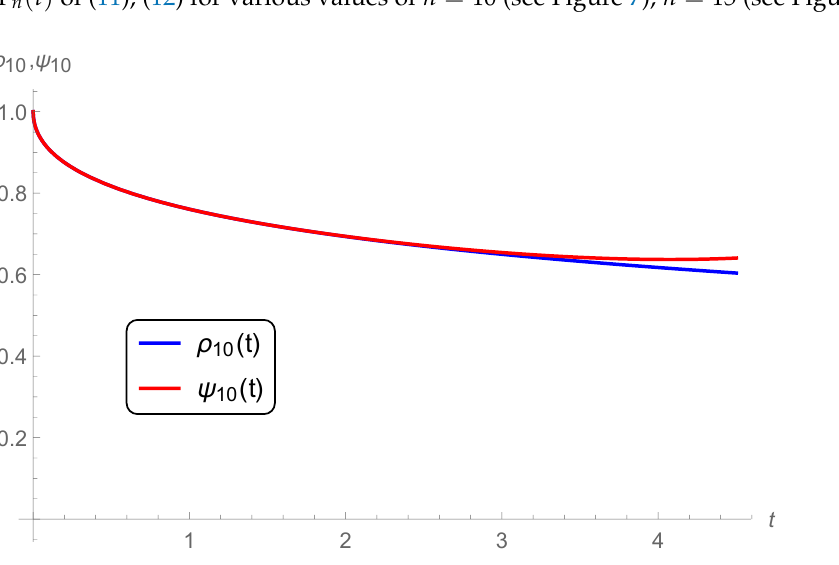
Figure 7. Graphs of the n -th approximate solutions ρ 10 ( t ) (present) and Ψ 10 ( t ) (Ref. [19]) for λ = 1, q = 1.4, and α =